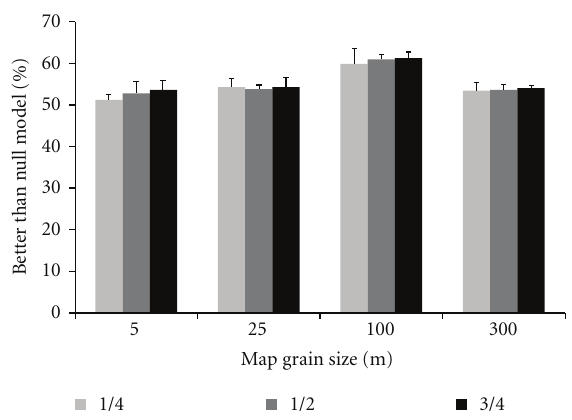
Figure 5: Mean (SE) performance of simulations with 10 move- ment resistances associated with open habitats relative to resistance assigned to young forests (1/4, 1/2, and 3/4), and across varying grain size. Performance was defined as the percentage of the 500 simulation for which mean distance was smaller than median of mean distances for the null model of the corresponding year.